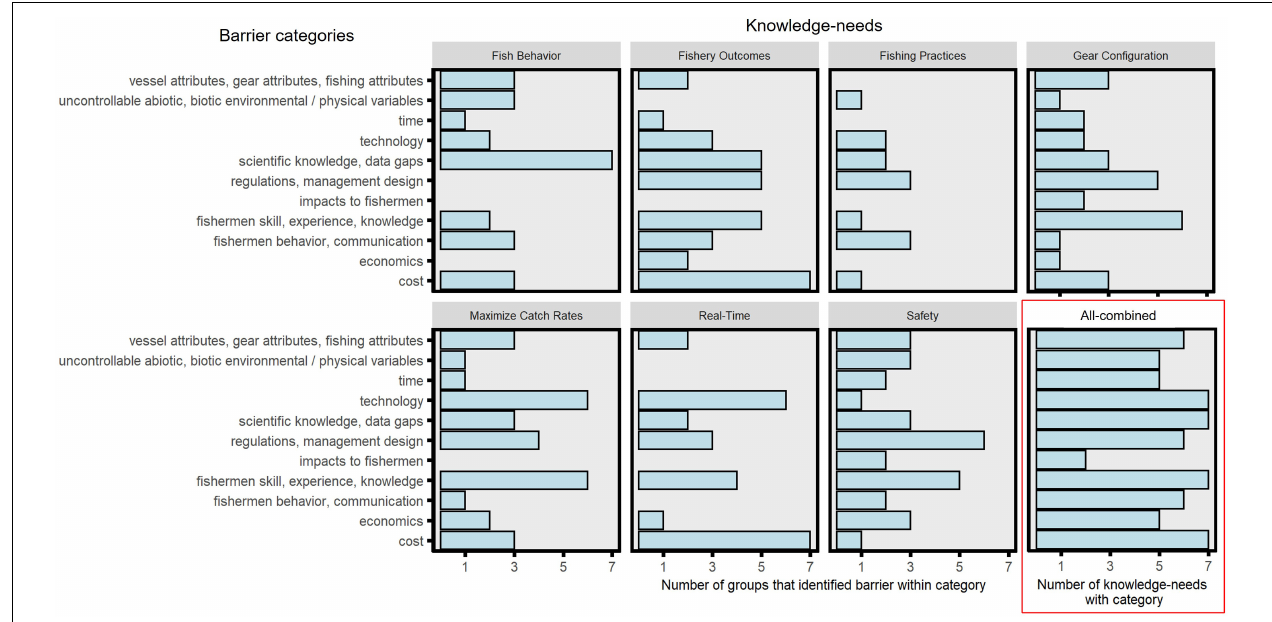
FIGURE 2 | Bar plots of barriers to knowledge-needs in trawl conservation engineering. Barriers of like categories were combined to create a single score for each category, creating 11 ‘barrier categories’ ( y -axis). The x -axis represents the number of break-out groups (range 1-7, out of 7) that identified a barrier within the barrier category on the y -axis. Plots are separated by the seven knowledge-needs discussed at the workshop. The “All Combined” plot (bottom-right, highlighted by a red box) depicts the number of times each barrier category was identified under the seven knowledge-needs combined (range 1 – 7). Note, three break-out groups were unable to complete the ‘Fishing Practices’ knowledge-need due to time